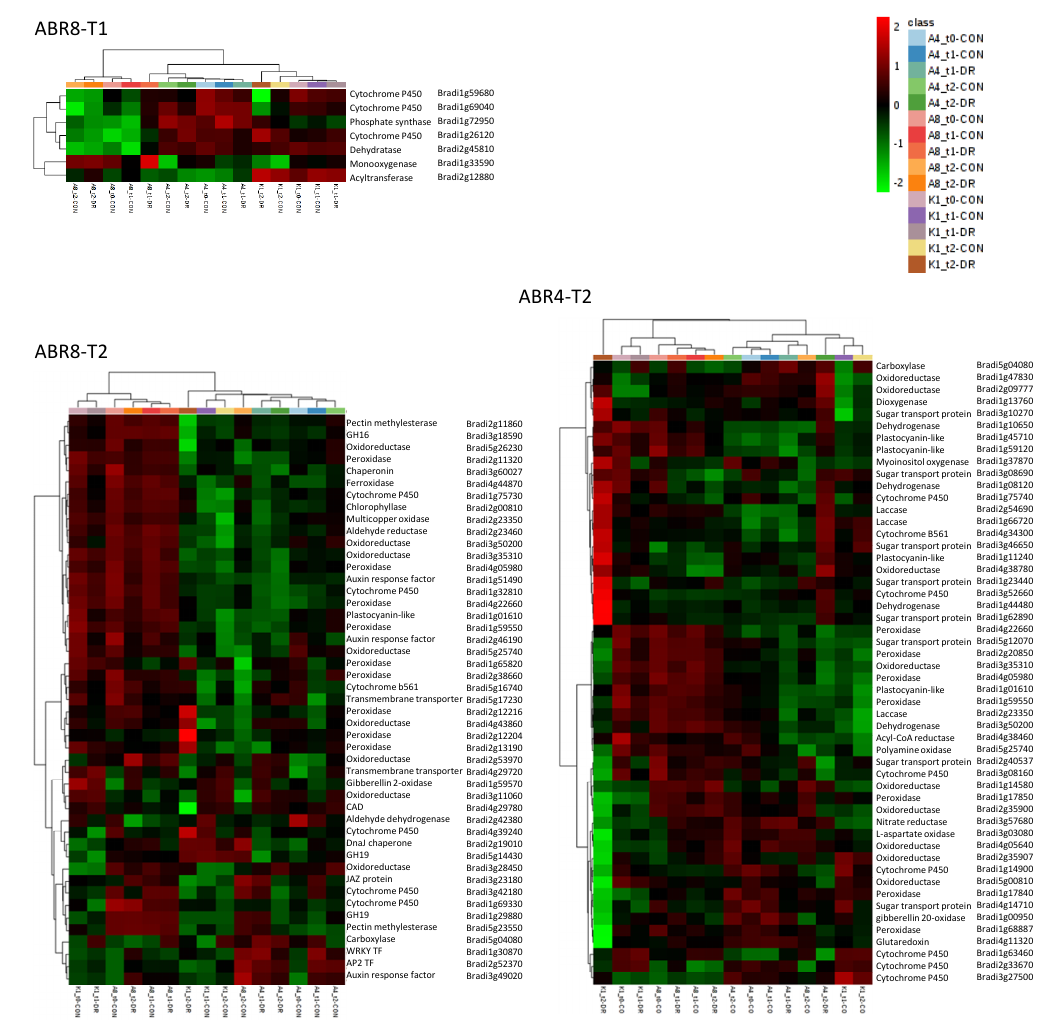
Figure 5. Heat map and cluster results for genes associated with GO enriched terms for ABR8-T1, ABR4-T2 and ABR8-T2. See Tables S3, S4 and S5 for more detailed descriptions of the genes underlying the enriched term for ABR8-T1, ABR4-T2 and ABR8-T2, respectively. Abbreviations: A4, ABR4; A8, ABR8; K1, KOZ1; CON, control; DR, drought; GH, glycoside hydrolase; TF, transcription factor. Heatmap shows normalized FPKM values